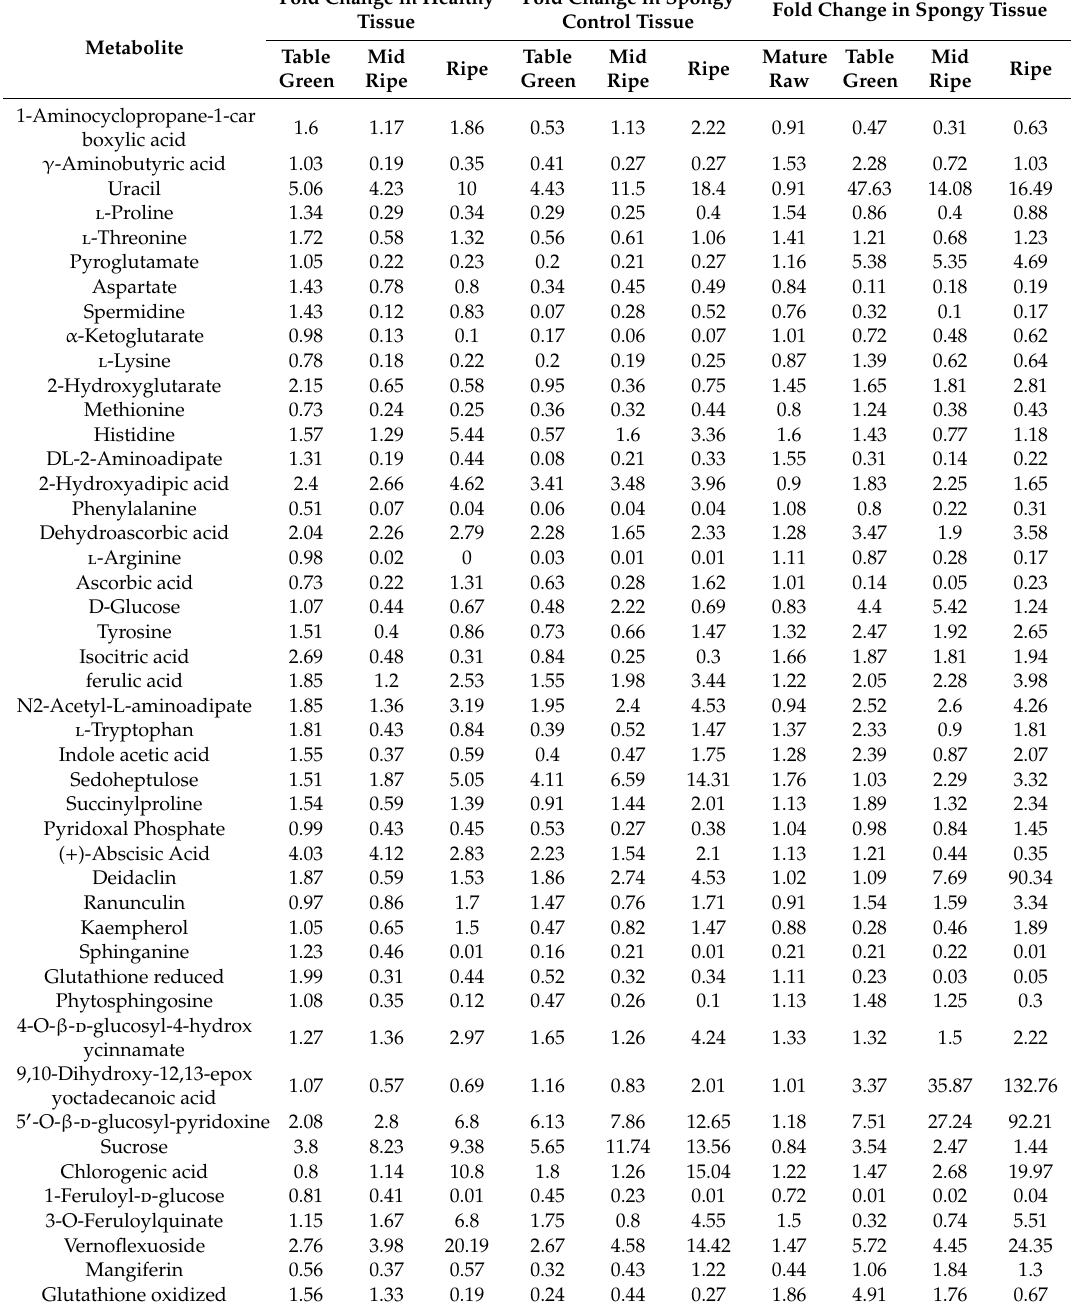
Table 2. Fold change variation in the putative metabolite composition within healthy, spongy and spongy control mesocarp tissue of mango. Fold change was calculated by considering the values of mature raw healthy stage as